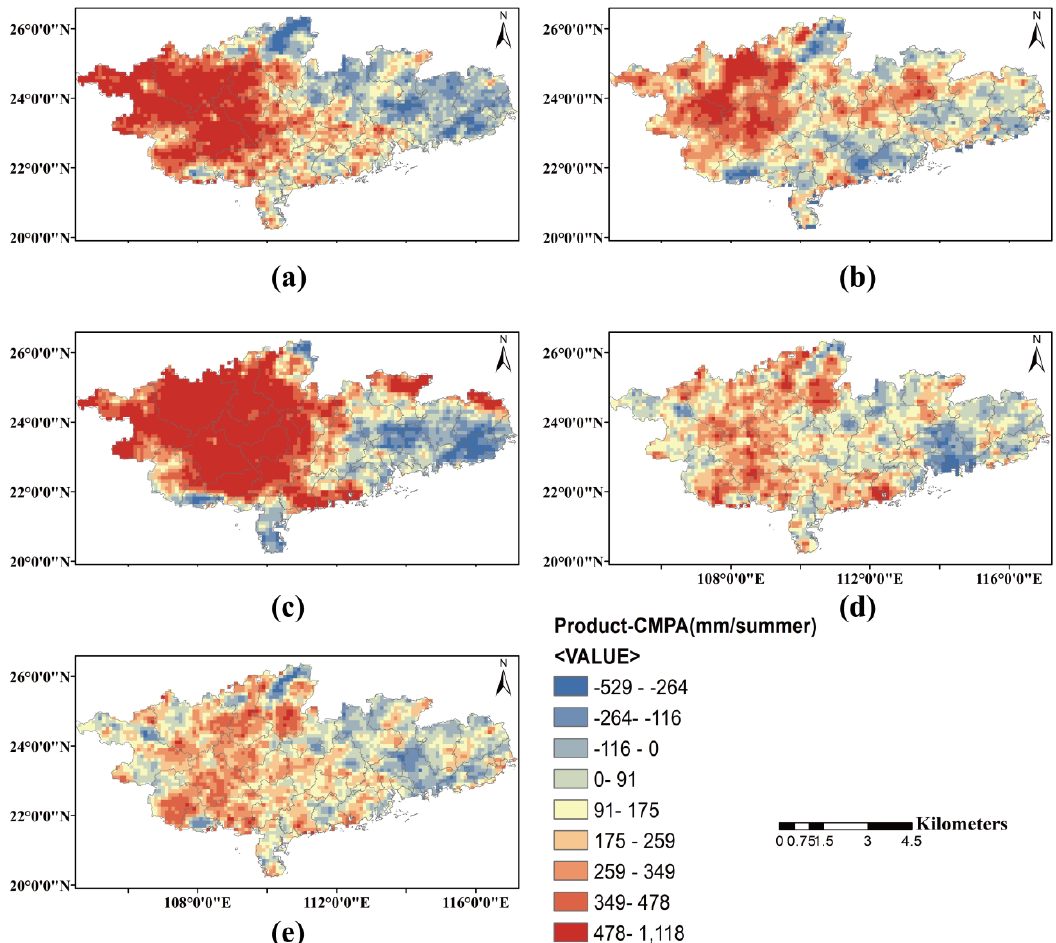
Figure 3. The spatial differentials of total rainfall estimated by ( a ) PERSIANN-CCS, ( b ) ERA5-Land, ( c ) FY-4A, ( d ) GSMaP, and ( e ) IMERG against CMPA over southern China in summer 2019.